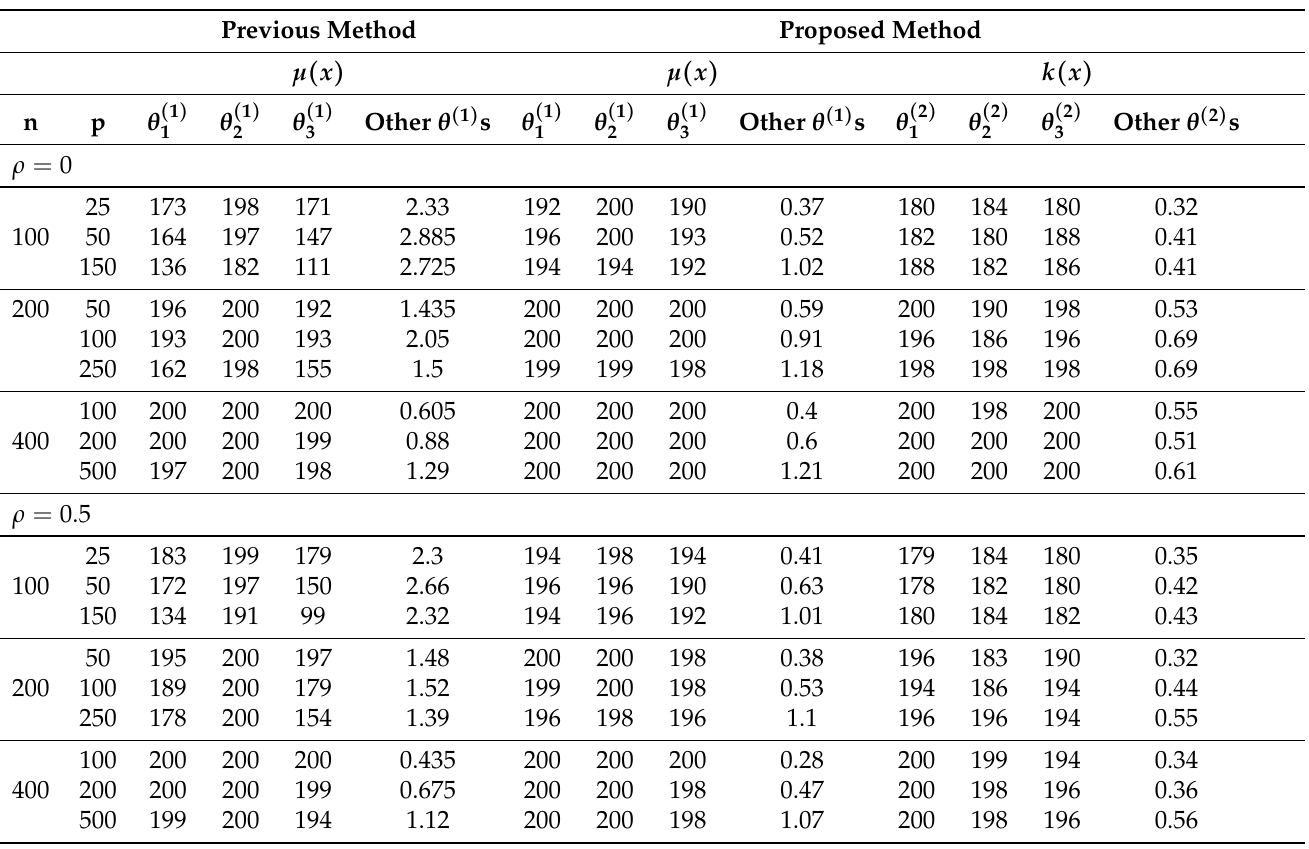
Table 2. The results of variable